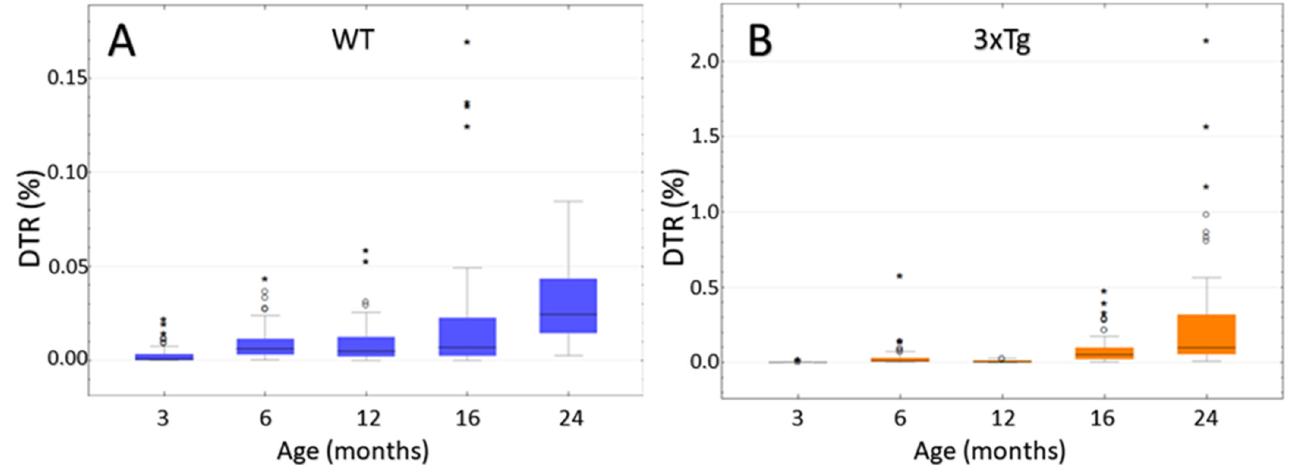
Figure 10. Age-dependency of hippocampal SP-G-immunopositive dot-to-tissue-ratios (DTR given as percentage). ( A ) WT mice: Since there is no significant difference between the 6, 12, and 16 month-old animals, these three groups were summarized as “middle-aged mice” and compared to the other two age groups. A significant difference in DTR could be shown between the young (3 months), middle-aged, and old WT-mice ( p < 0.001 for both group comparisons; Kruskal-Wallis Test) with a clear increase over the course of aging. ( B ) 3xTg mice: No significant differences in DTR could be shown between the 6 and 12 month-old animals ( p = 0.125; Kruskal-Wallis Test) and the 16 and ca. 24 month-old animals ( p = 0.438; Kruskal-Wallis Test). Comparisons of all the other age groups showed highly significant differences (each p < 0.001; Kruskal-Wallis Test) with a clear increase of DTR during aging. Remarkably, in one old animal, 2.14% of the hippocampal area was occupied by SP-G-mmunoreactive dots. Notice that the ordinate is scaled differently in both graphs. ◦ : Indicates data values lying 1.5 to 3 × of the IQR above the mean value. *: Indicates data values lying >3 × of the IQR above the mean